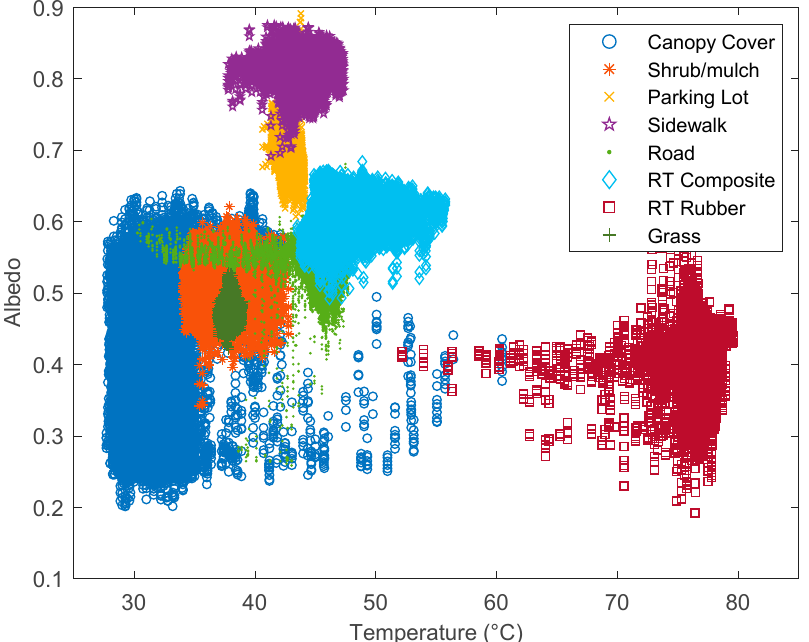
Figure 8. Surface temperature data plotted against albedo from a flight recorded on 11 August 2018.